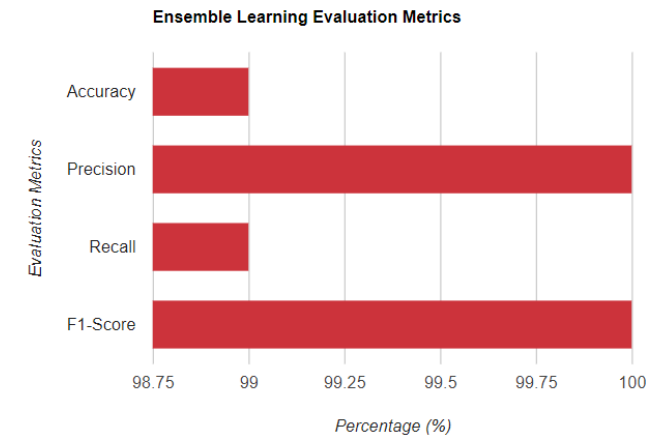
Figure 10. The Ensemble Learning Evaluation Metrics.